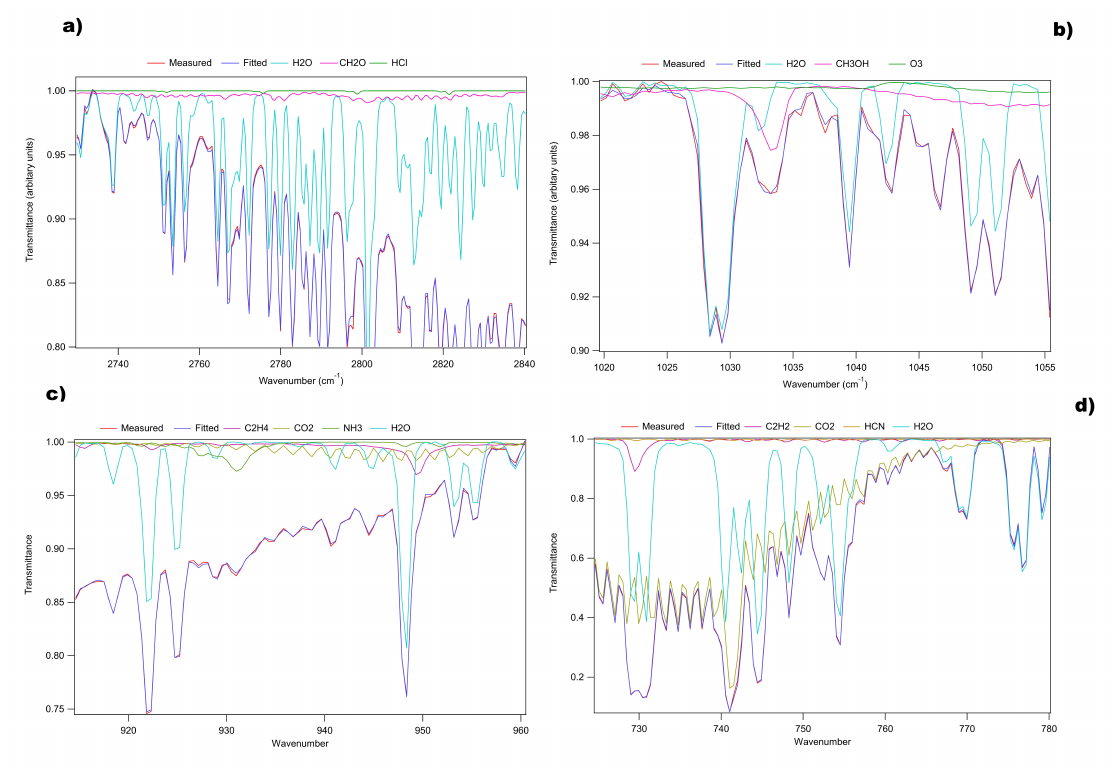
Figure 2. Example Multiple Atmospheric Layer Transmission (MALT) spectra fittings for ( a ) CH ( b ) CH OH, ( c ) C H and ( d ) C H 3 2 4 2 2